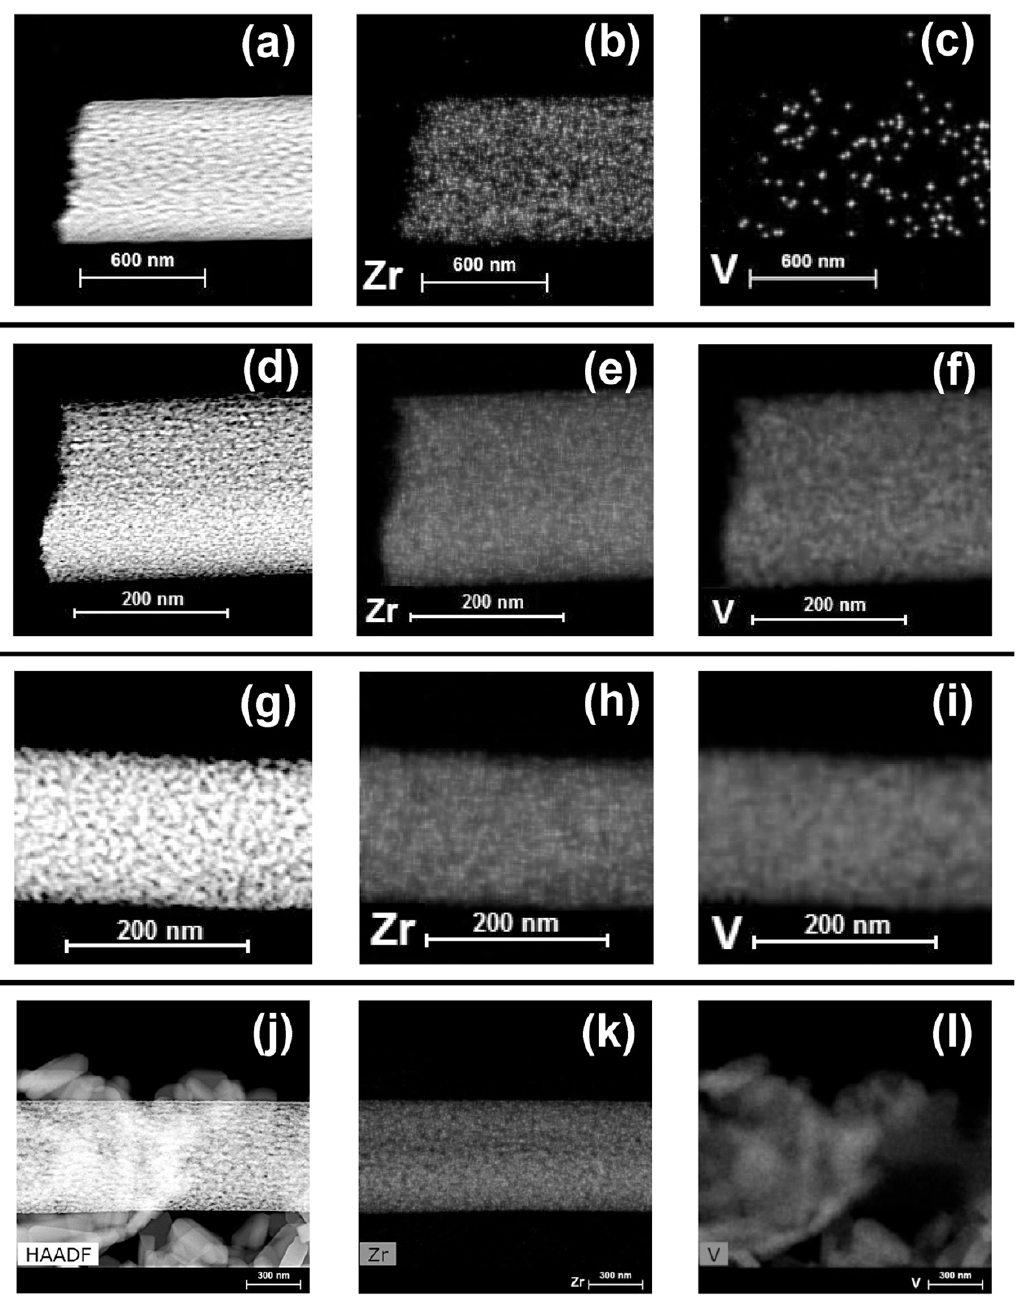
Figure 5. HAADF-STEM images and EDXA elemental mappings of Zr and V for the electrospun fibers with different V compositions. F-PZr ( a – c ), F-PZr-V5.0 ( d – f ), F-PZr-V13.3 ( g – i ), and FI-PZr-V5.0 ( j – l ). Note that the scale of each figure has been adapted to the size of the sample. Reproduced from [97] with permission from the copyright owner (Elsevier 2019) [97].